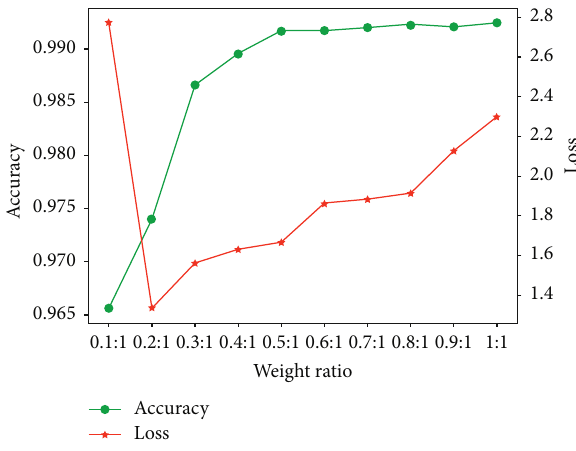
Figure 5: Testing results of different weight ratios. Table 4: Experimental results of different modes.